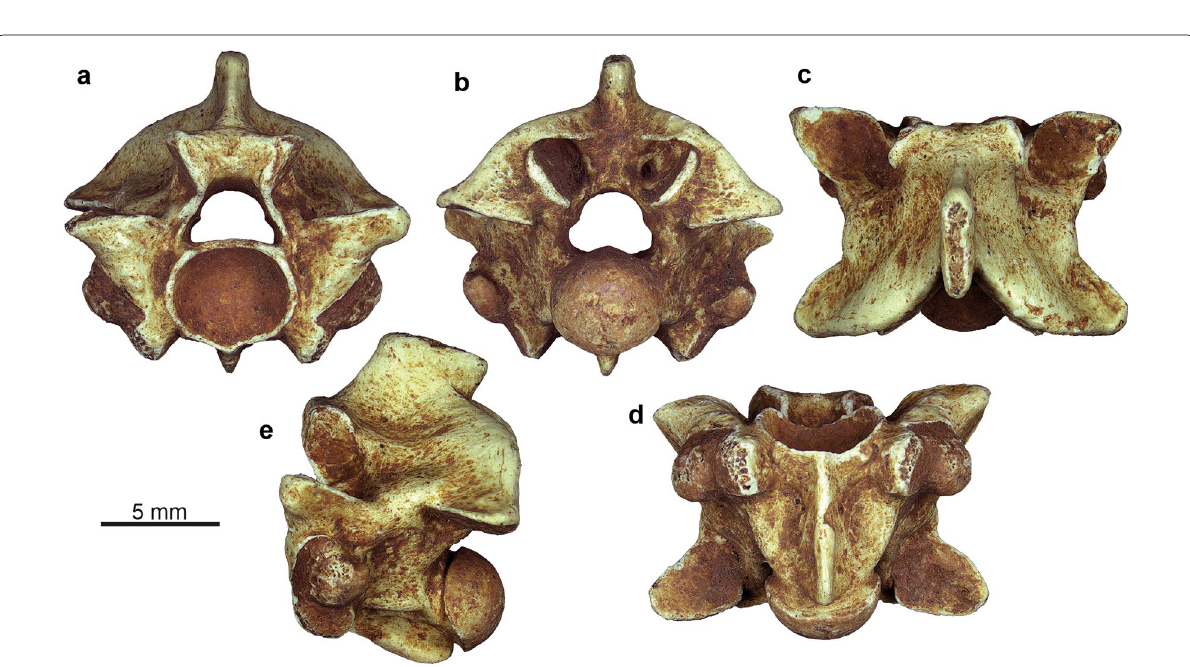
Fig. 81 Phosphoroboa filholii comb. nov. from an imprecisely known locality in the Phosphorites du Quercy: anterior mid-trunk vertebra (NHMW 2019/0033/0054) in anterior ( a ), posterior ( b ), dorsal ( c ), ventral ( d ), and left lateral ( e )